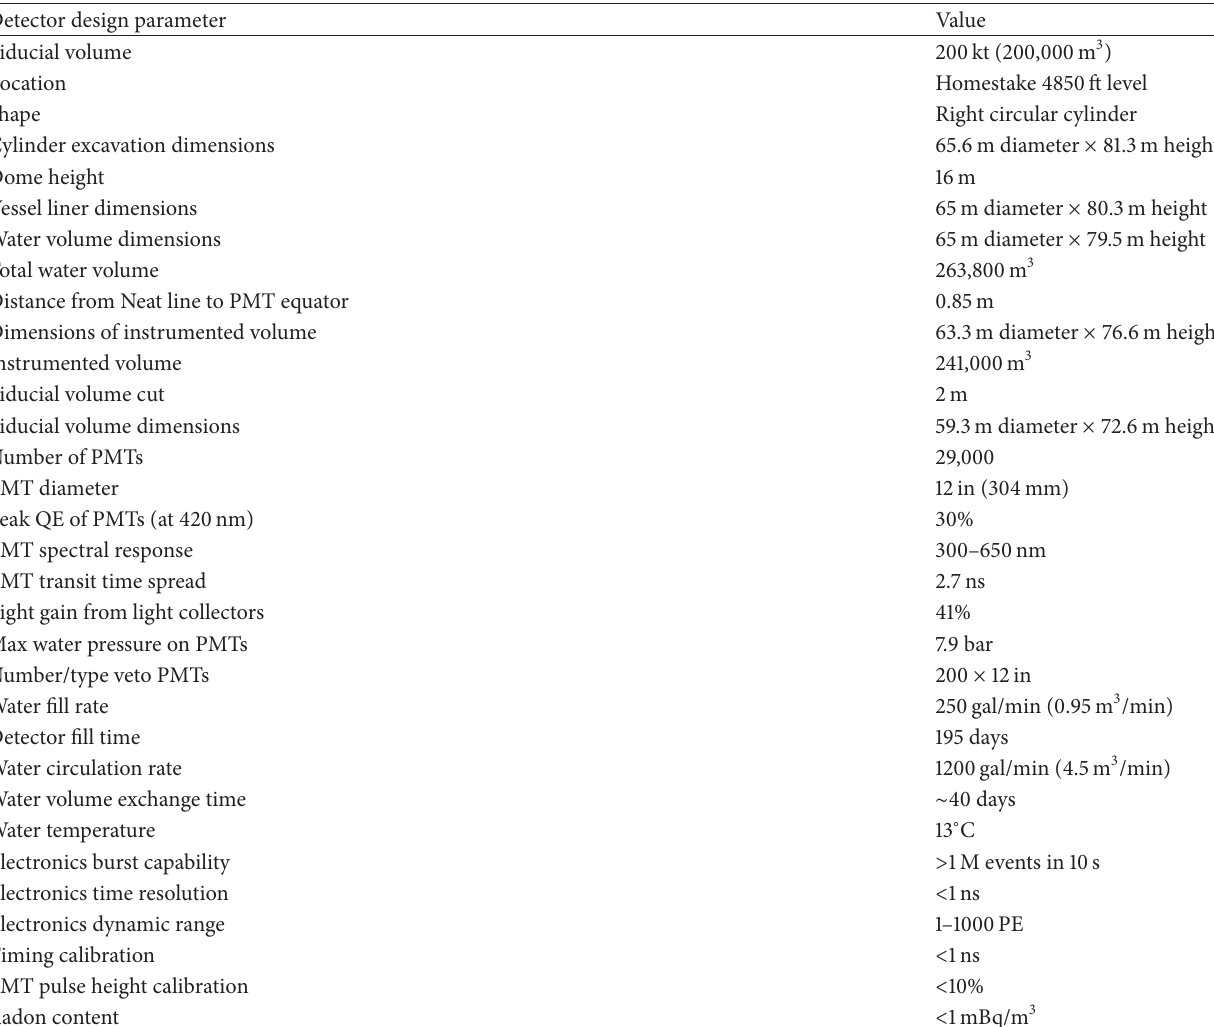
Table 1: A summary of the important water Cherenkov detector design